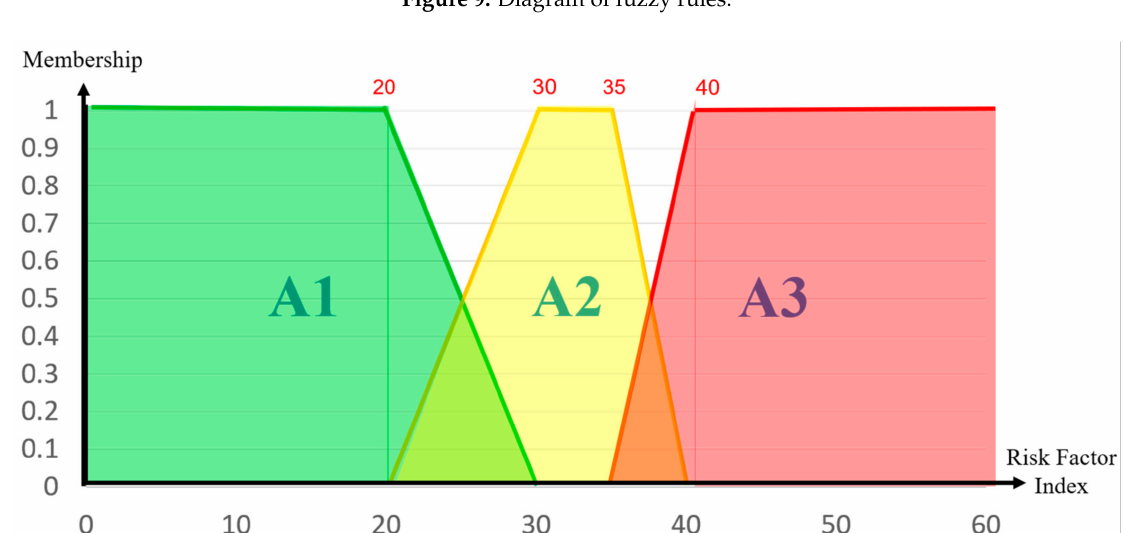
Figure 9. Diagram of fuzzy rules.